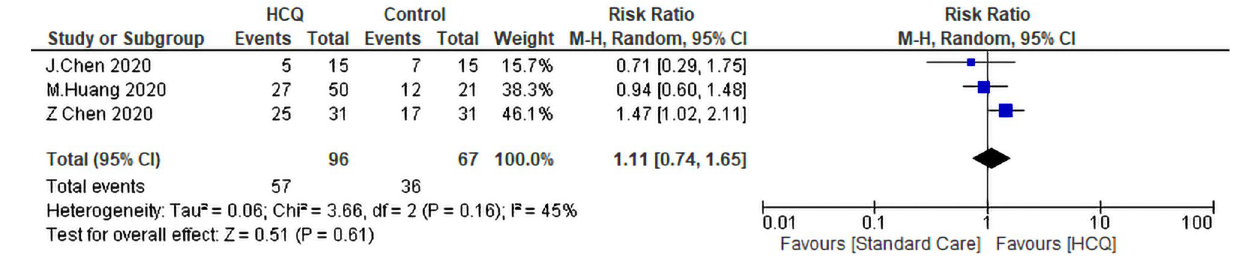
Figure 11. Forest plot for pooling risk ratios regarding radiological improvement.